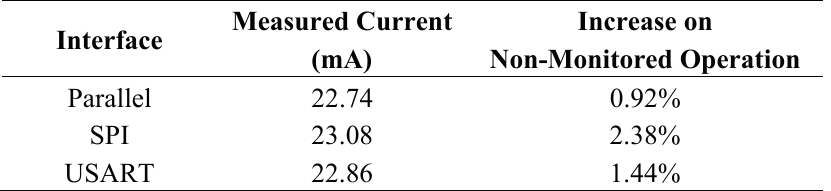
Table 6. Current increment due to monitoring operation by